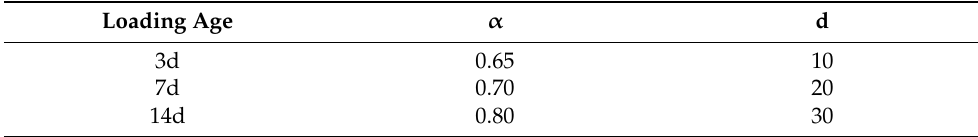
Table 5. The values of α and d for various loading ages.